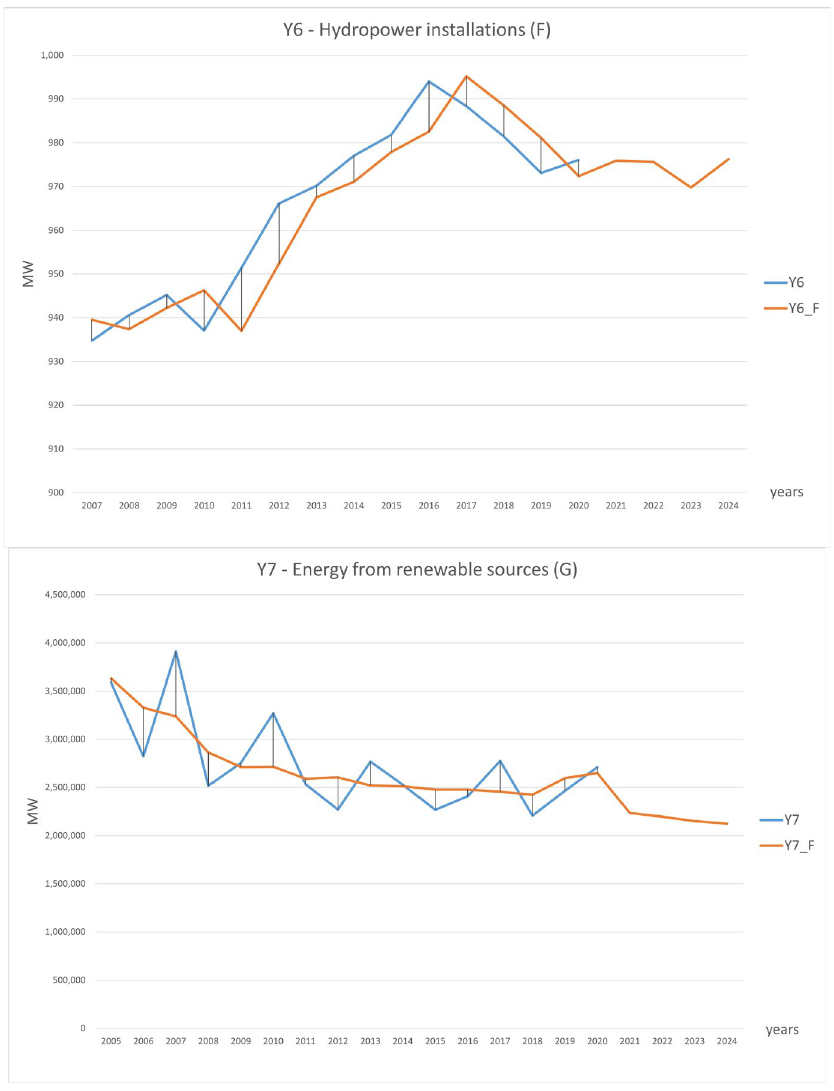
Figure 9. Graphs presenting the actual values of the forecasted variables Y t and the values of the calculated Y t_F forecasts. Source: Own study.